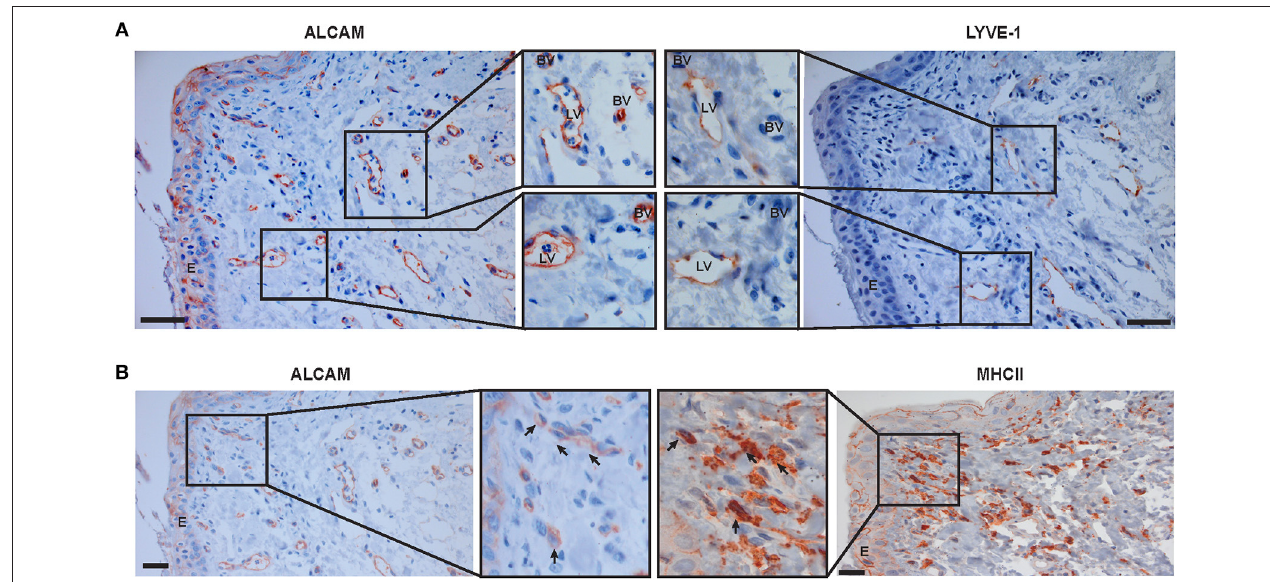
FIGURE 8 | ALCAM is expressed in pathologic blood and lymphatic vessels in neovascularized human corneas and in corneal DCs. Serial sections of inflamed human corneas obtained from high risk transplant patients were stained for (A) ALCAM and LYVE-1 and (B) ALCAM and MHC-II. Magnifications of the boxed areas are shown in the center part of the Figure. LV, Lymphatic vessel; BV, Blood vessel, E, epithelium. Arrows indicate specific staining. Scale bar: 20 µ m. Representative images from 3 stained neovascularized corneas are